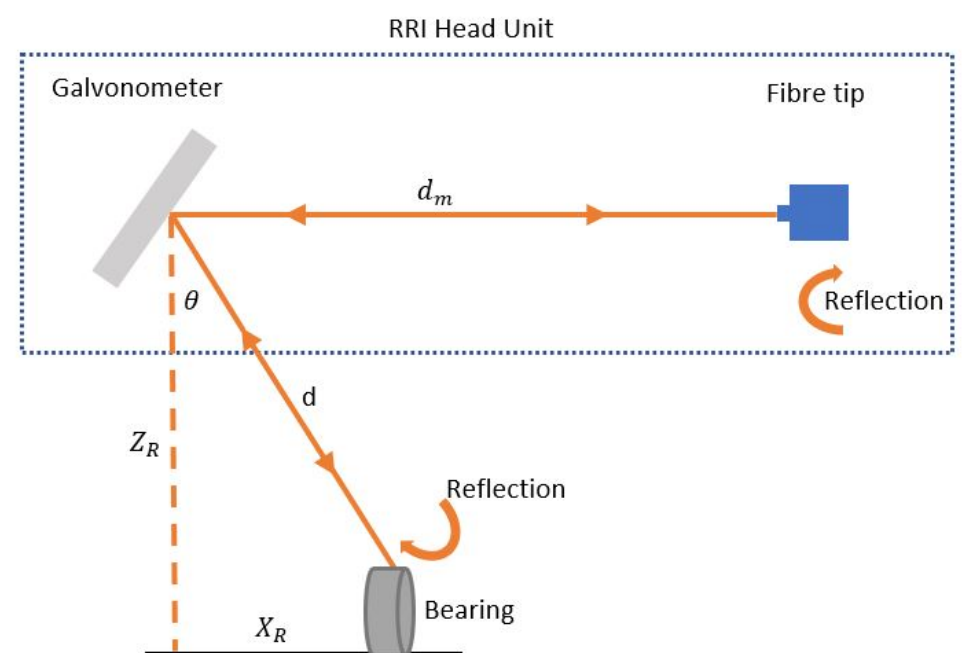
Figure 3. Interferometry for 2D implementation using scanned range-resolved interferometry.